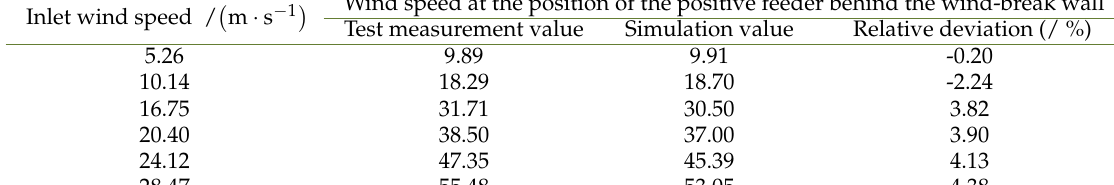
Table 2. Comparison of test results and simulation calculation under different inlet wind speeds (cid:0) (cid:1) Inlet wind speed / m · s − 1